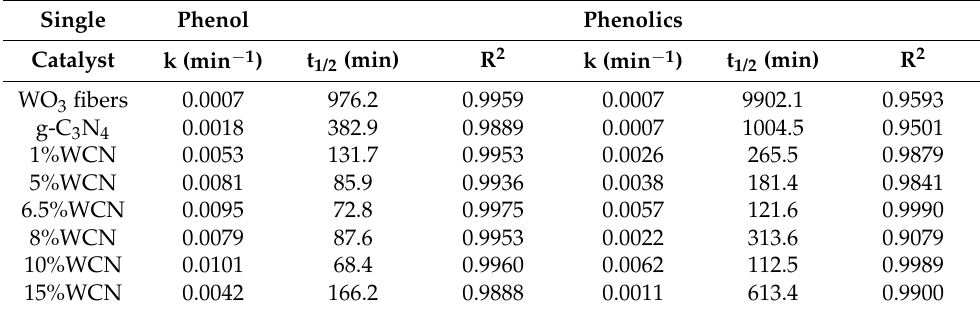
Table 2. Photocatalytic degradation kinetics (k, min − 1 ; t 1/2 , min; R 2 ) of phenol and phenolic compounds in single system.